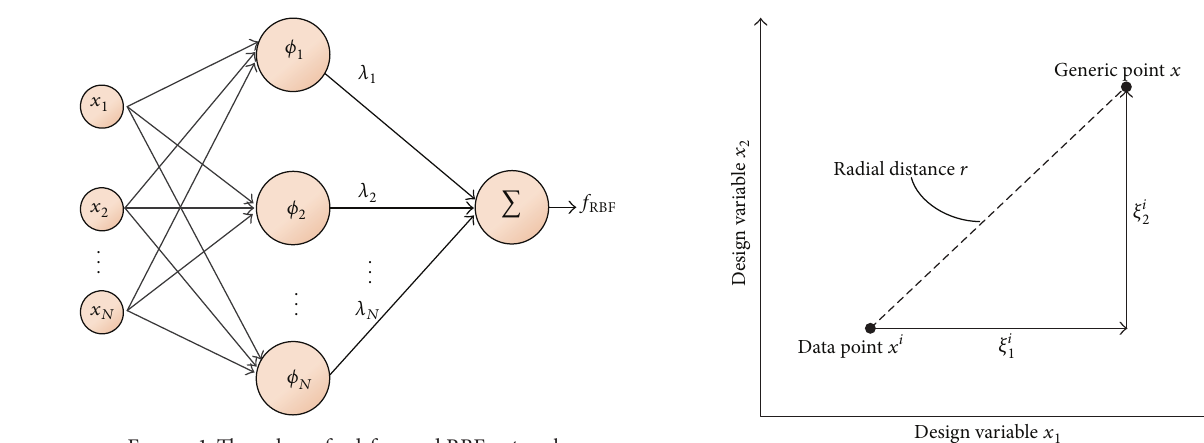
Figure 1: Three-layer feed-forward RBF network. Table 1: Commonly used basis functions.